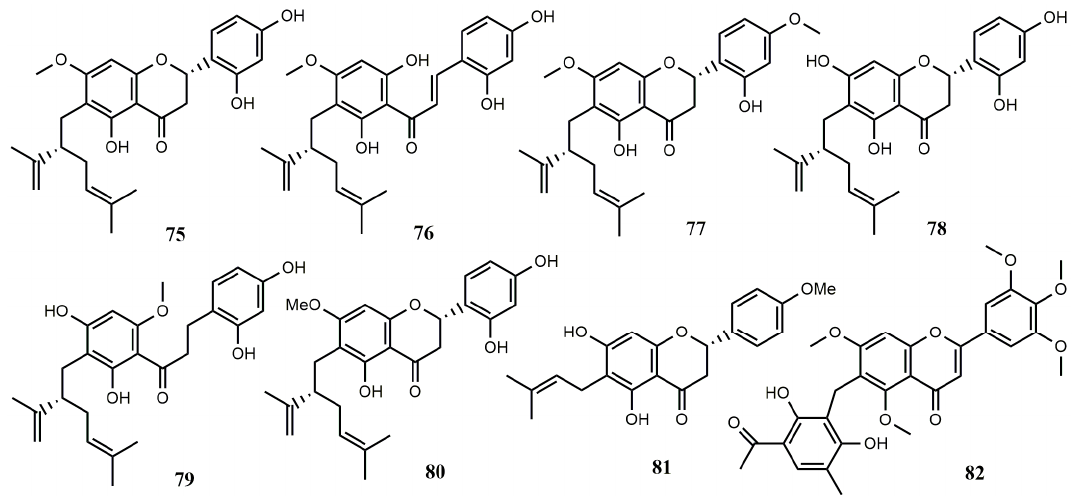
Figure 6. Reported structures of complex flavonoids 67 – 74 from fungi and actinomycetes.